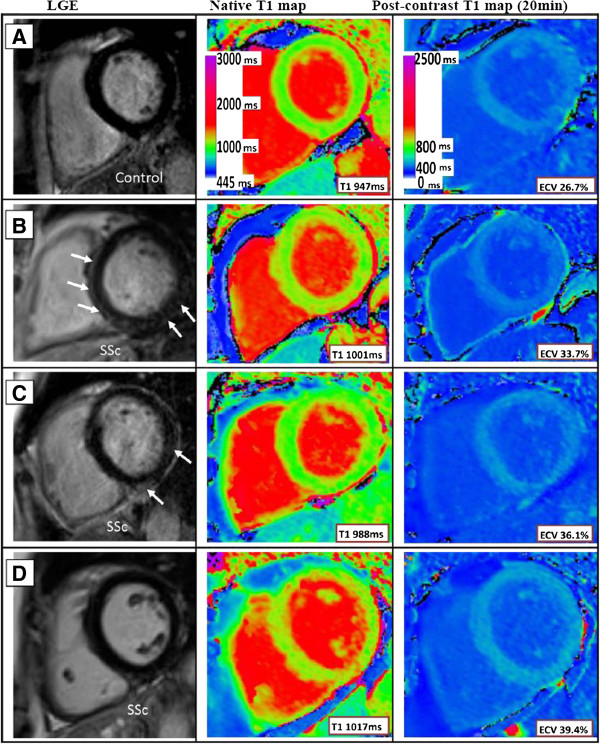
Representative examples of pre- and postcontrast T1 maps with corresponding LGE images in SSc and controls. Top panel (A): normal control with no LGE, native T1 947 ms, postcontrast T1 514 ms, ECV 26.7%; Second panel (B): SSc patient with linear septal and patchy basal inferolateral LGE, native T1 1001 ms; postcontrast T1 453 ms; ECV 33.7%; Third panel (C): SSc patient with small areas of mid-wall inferior and lateral LGE, native T1 988 ms, postcontrast T1 439 ms, ECV 36.1%; Fourth panel (D): SSc patient with no LGE, native T1 1017 ms, postcontrast T1 421 ms, ECV 39.4%. LGE, late gadolinium enhancement. Note the scale change between precontrast and postcontrast T1 maps.